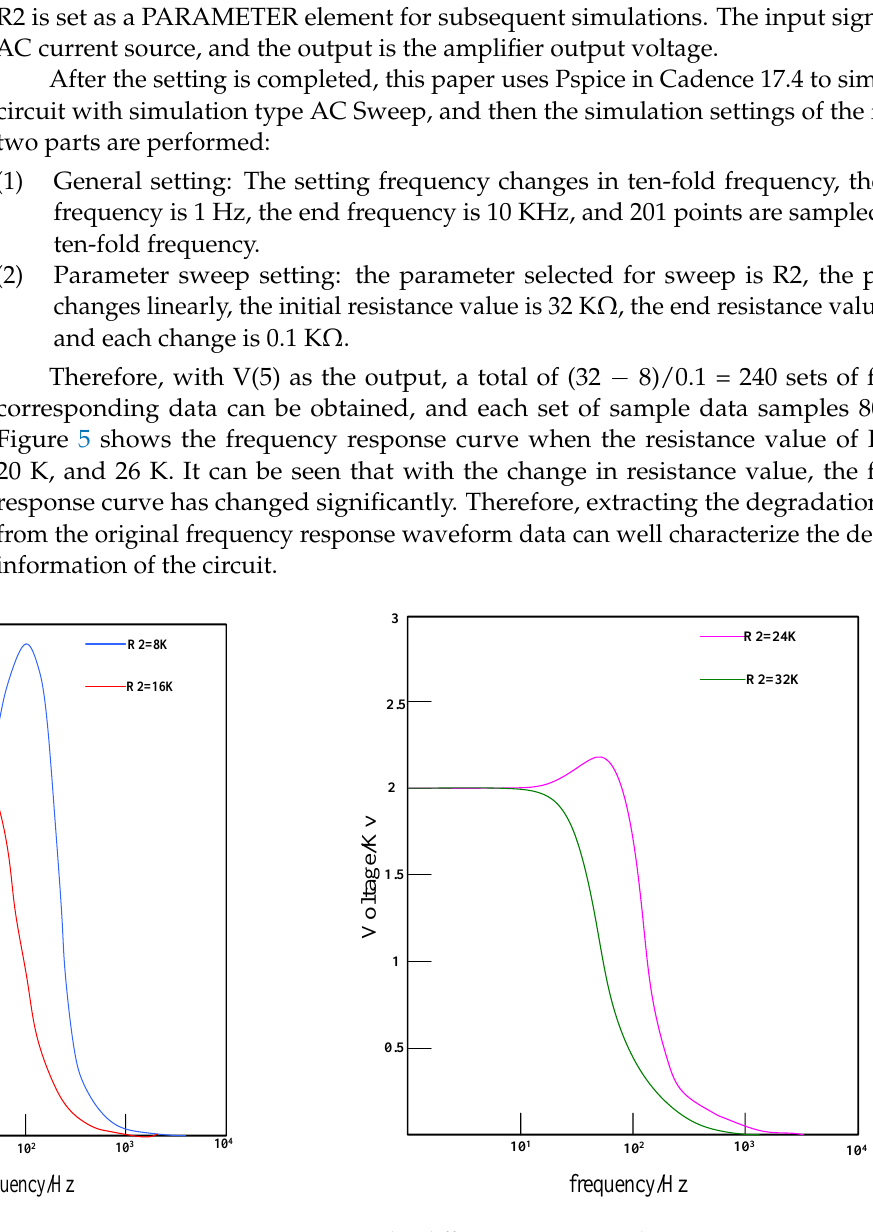
Figure 5. Frequency response curve under different resistance values.